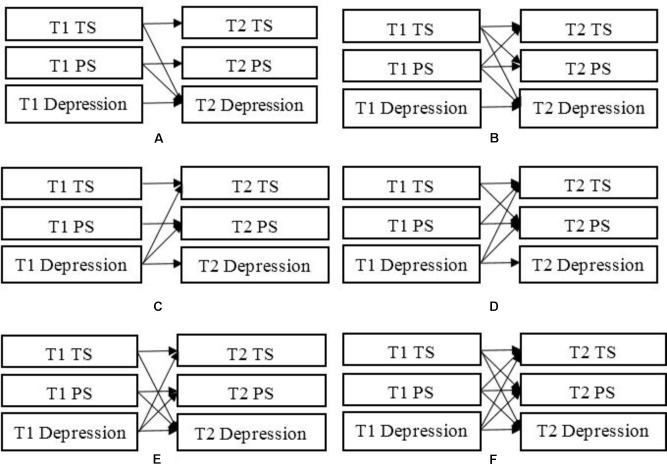
Steps to test the reciprocal effects between teacher support, peer support, and depression. (A) tested teacher support and peer support on depression; (B) added the reciprocal effects between teacher support and peer support on A; (C) examined the effect of depression on teacher support and peer support; (D) added the reciprocal effects between teacher support and peer support on C; (E) combined A and C; (F) combined B and D. TS, teacher support; PS, peer support; T1, Time 1; T2, Time2.